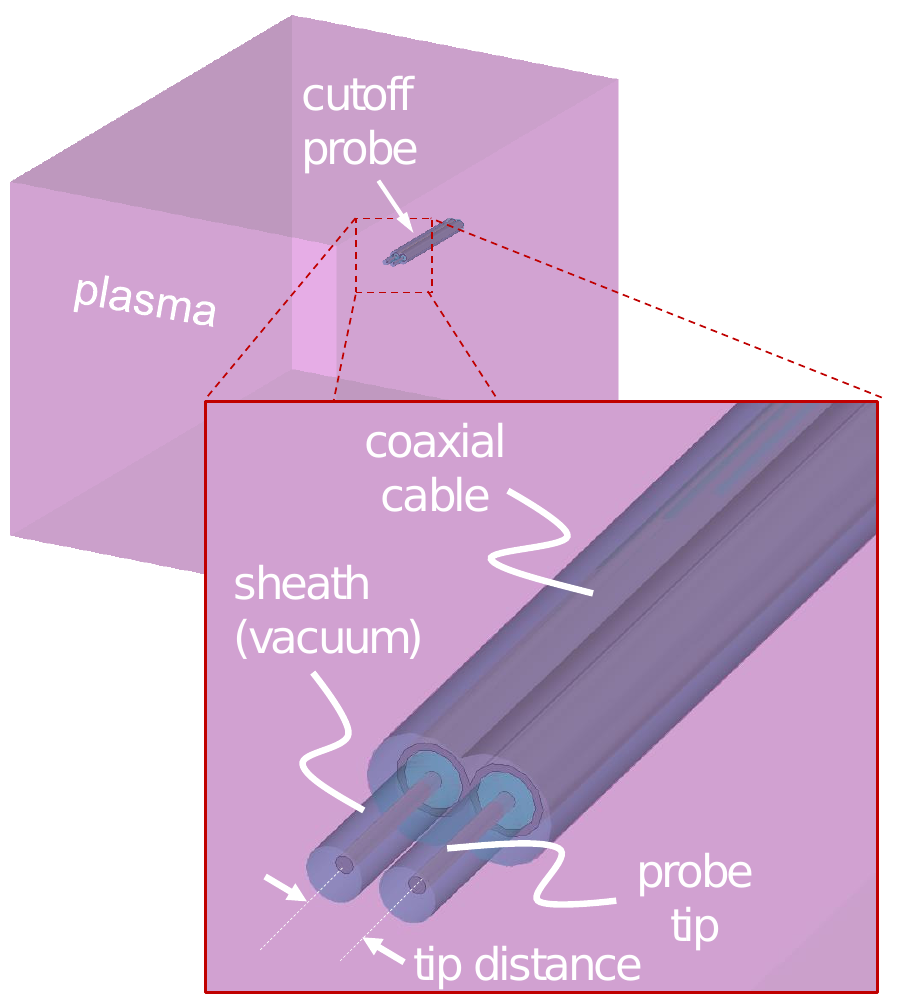
Figure 1. Configuration in a three-dimensional electromagnetic wave